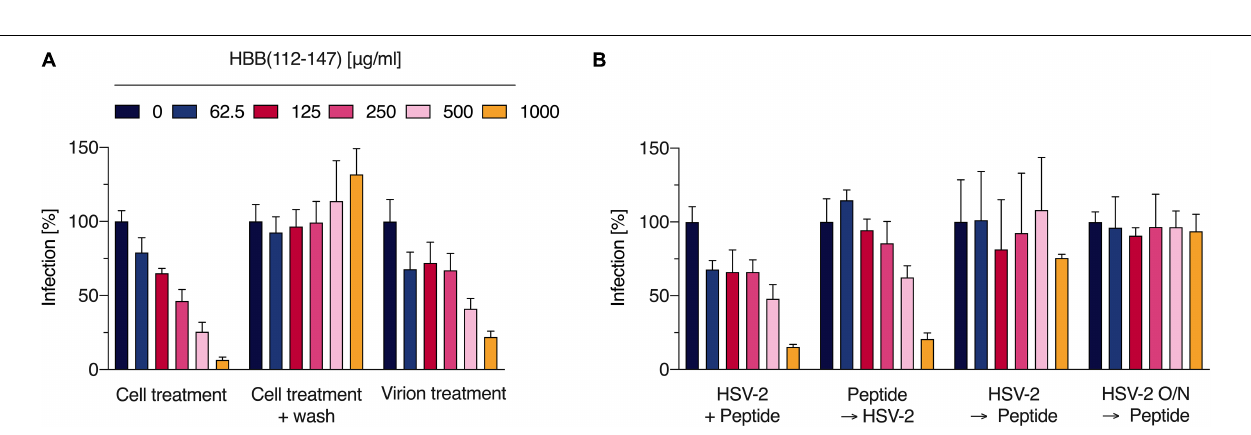
FIGURE 2 | The hemoglobin fragment blocks an early step in the HSV-2 life cycle. (A) Indicated concentrations of HBB(112–147) were added to cells and incubated for 30 min. Thereafter, cells were either infected directly with HSV-2 (cell treatment) or washed, supplemented with fresh medium and then infected (wash). Additionally, virus was first exposed to HBB(112–147) for 3 h at indicated concentrations, and then these mixtures were used to infect cells (resulting in a 20-fold dilution of the inoculum). Infection rates were determined 2 days later by quantifying β -galactosidase activities in cellular lysates. Shown are average values derived from two experiments each performed in quadruplicates + SD. (B) In order to determine which stage of infection HBB(112–147) interferes with, peptide at indicated concentrations was either added to cells directly prior to infection, pre-incubated for 30 min on cells at 37 ◦ C, added 2 h post-infection (with removal of virus and addition of fresh medium), or added after overnight infection (16 hpi). Infection was evaluated by quantifying β -galactosidase activities in cellular lysates 24 hpi. Shown are average values derived from one experiment in triplicates + SD.